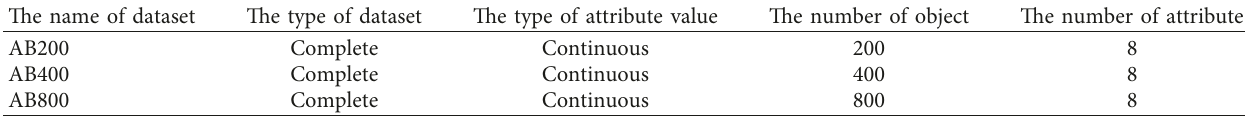
Table 11: The subsets of Abalone dataset used in Experiments 3 and 4.